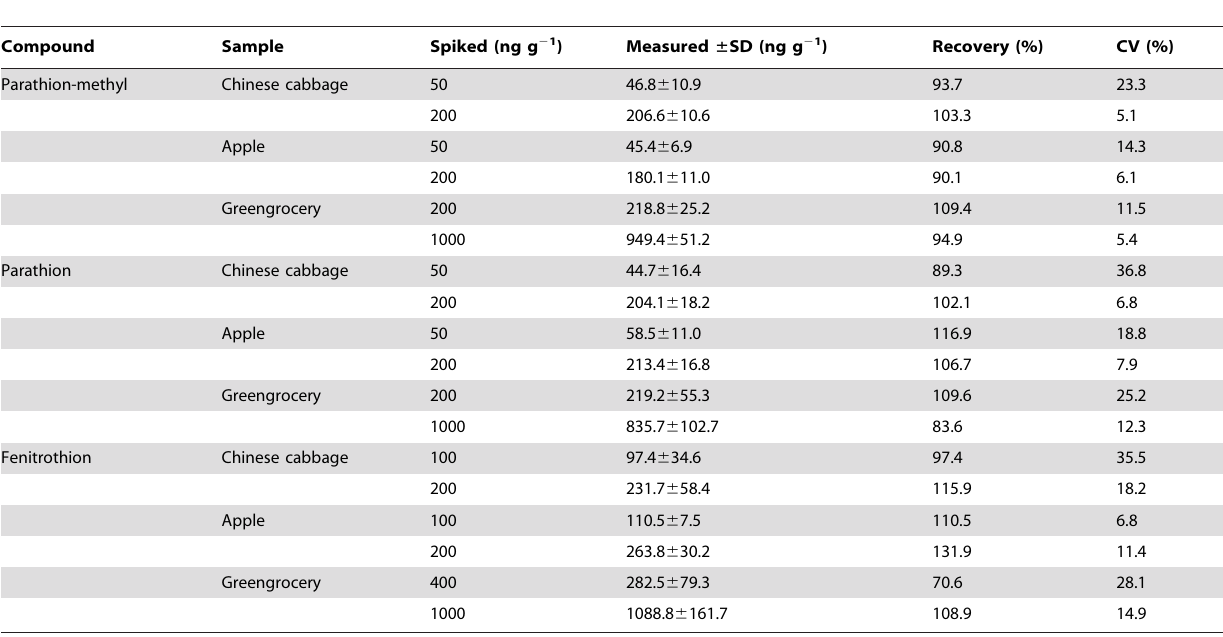
Compound Sample Spiked (ng g 2 1